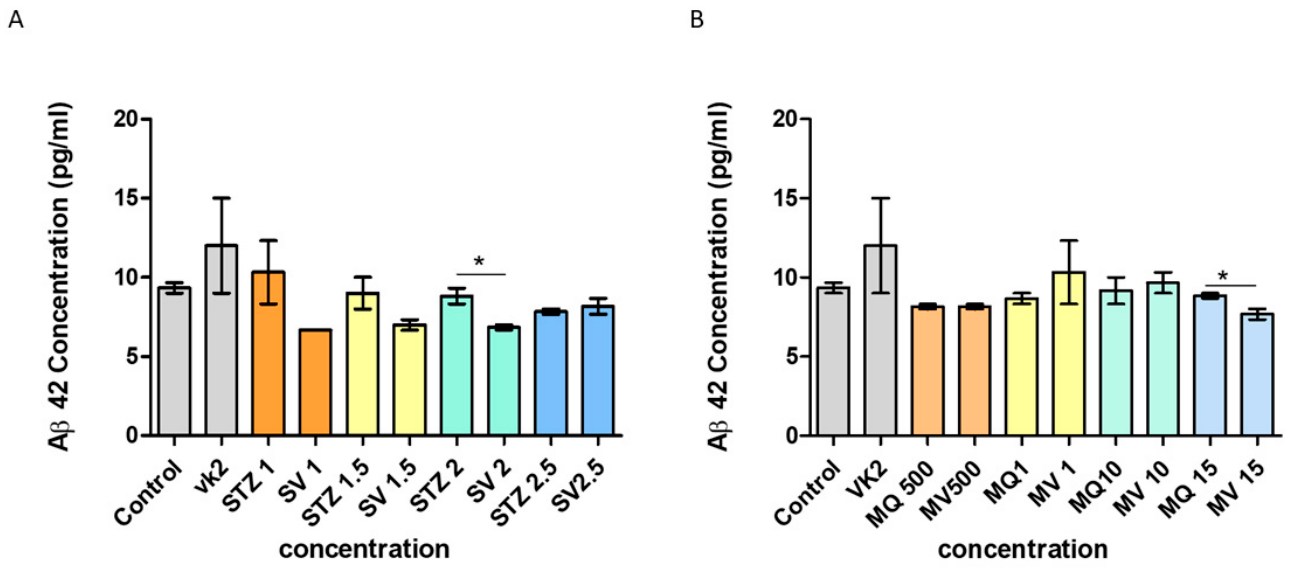
Figure 9. Measurement of secreted A β 42 protein levels by ELISA in human SH-SY5Y neuroblastoma cells after ( A ) streptozotocin treatment and post-treatment with vitamin K2 (50 µ M) and ( B ) menadione treatment (MQ) and post-treatment with vitamin K2. A best-fit standard curve was plotted for the known protein concentrations using Graphpad Prism and absorbance values for unknown samples were interpolated on the standard curve to determine the concentration of target protein in each sample. The data are presented as mean ± SEM. Statistical analysis was performed using Student’s t -test and differences with p -values ≤ 0.05 were designated as significant. * p < 0.05, ** p < 0.01, and *** p < 0.001 denote significant differences compared to the control and between the treatment groups. [STZ—streptozotocin; VK2—vitamin K2; SV—post-treatment of streptozotocin (1–2.5 mM)-treated cells with vitamin K2 (50 µM); MQ—menadione; MV—post-treatment of menadione (500 nM–15 µM)-treated cells with vitamin K2 (50 µM)].